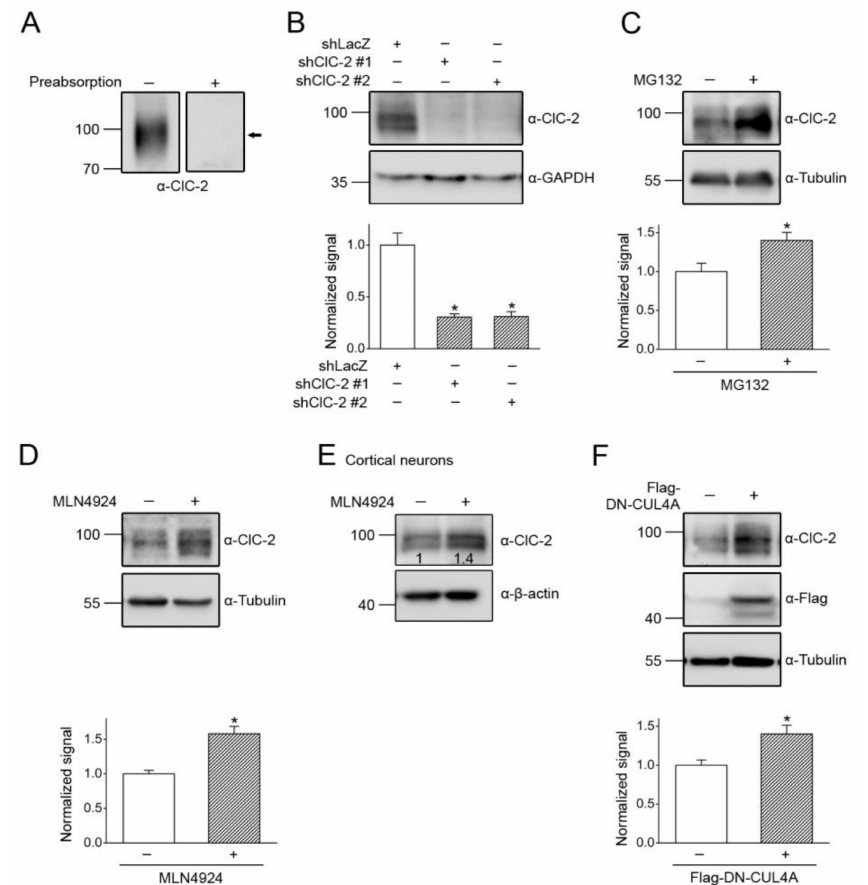
Figure 5. Regulation of endogenous ClC-2 expression by CUL4. ( A ) ( Left ) Endogenous expression of ClC-2 in the mouse testis. ( Right ) Verification of the specificity of α -ClC-2 in testes. Mouse ClC-2 protein detection was prevented by preabsorbing the immunoblot with a control antigen peptide. The protein band corresponding to mouse ClC-2 is highlighted with the black arrow. ( B ) ( Upper panel ) Representative immunoblot showing the e ff ect of shRNA knockdown on the endogenous expression of ClC-2 in the mouse MA-10 Leydig cell. ClC-2 protein detection in MA-10 cells was prevented by infection with shRNA targeting specific mouse ClC-2 sequences (shClC-1 #1 and #2). shRNA targeting a LacZ sequence (shLacZ) was used as the control experiment. ( Lower panel ) Quantification of relative ClC-2 protein levels. Protein density was standardized as the ratio of the ClC-2 signal to the cognate GAPDH signal. Values from the shClC-2 groups ( hatched bars ) were then normalized to those for the corresponding shLacZ control ( clear bar ). Asterisk denotes a significant di ff erence from the control (*, t test: p < 0.05; n = 4). ( C ) ( Upper panel ) Representative immunoblot showing the e ff ect of the 24-h treatment of 10 µ M MG132 on endogenous ClC-2 expression in MA-10 cells. ( Lower panel ) Quantification of the relative ClC-2 protein levels (*, t test: p < 0.05; n = 5). ( D ) ( Upper panel ) Representative immunoblot showing the e ff ect of the 24-h treatment of 10 µ M MLN4924 on endogenous ClC-2 expression in MA-10 cells. ( Lower panel ) Quantification of relative ClC-2 protein levels (*, t test: p < 0.05; n = 7). ( E ) Representative immunoblot showing the e ff ect of MLN4924 treatment on endogenous ClC-2 expression in cultured rat cortical neurons. The numbers on the immunoblot denote the relative ClC-2 protein levels. ( F ) ( Upper panel ) Representative immunoblot showing the e ff ect of Flag-DN-CUL4A overexpression on endogenous ClC-2 expression in MA-10 cells. Co-expression with the Flag vector was used as the control experiment. ( Lower panel ) Quantification of the relative ClC-2 protein levels (*, t test: p < 0.05; n =